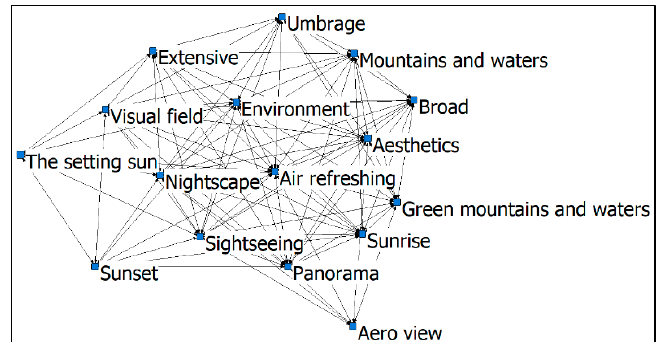
Figure 7. 1-1. Natural landscape based on visual and olfactory interactive perception.